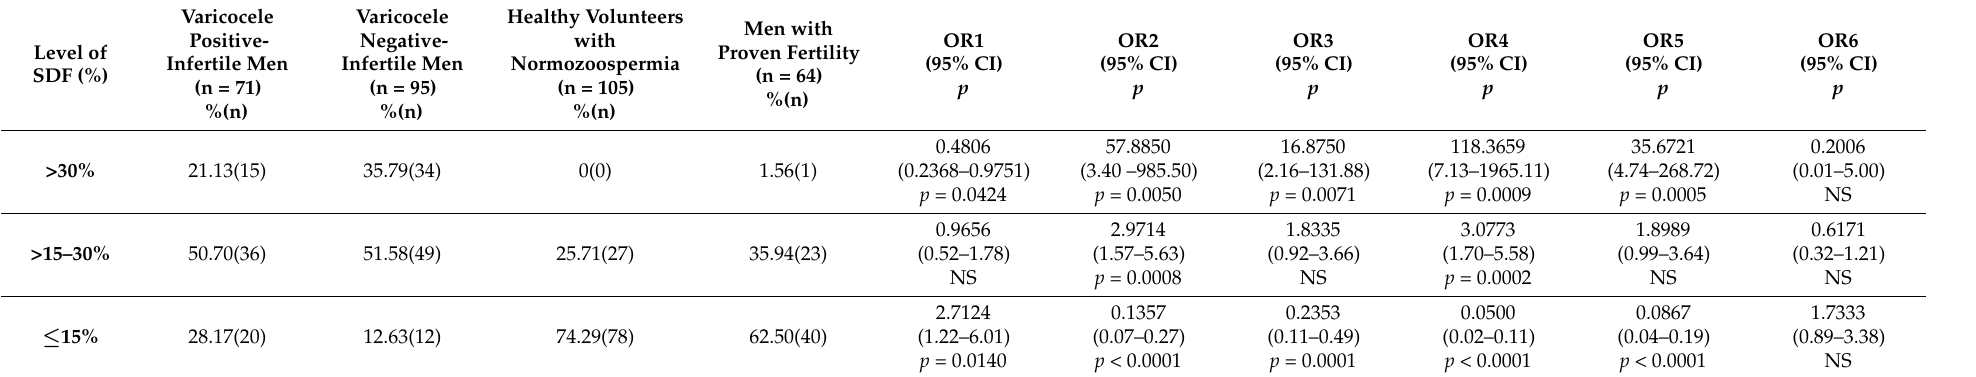
Table 3. Odds ratio for SDF in study